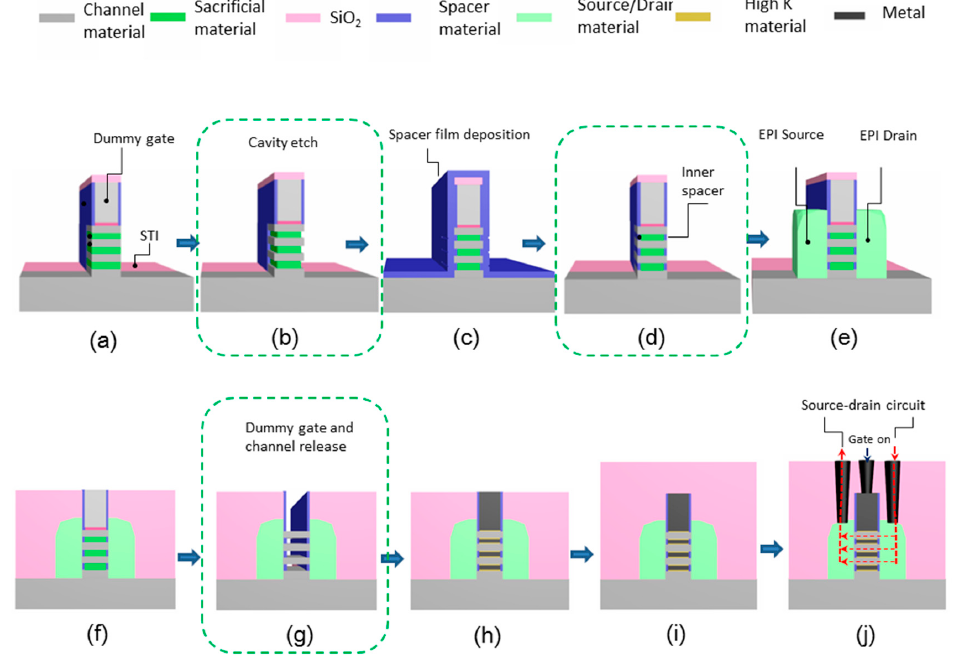
Figure 32. Process flow and critical etching steps for manufacturing lateral nanowire GAA device: ( a ) Source/drain Fin recess for opening active area, ( b ) cavity etching for defining the growth position and size of the inner spacer, ( c ) inner spacer film deposition, ( d ) controlled etching of spacer film and formation of inner spacer, ( e ) source/drain epitaxial growth, ( f ) dielectric deposition and planarization,